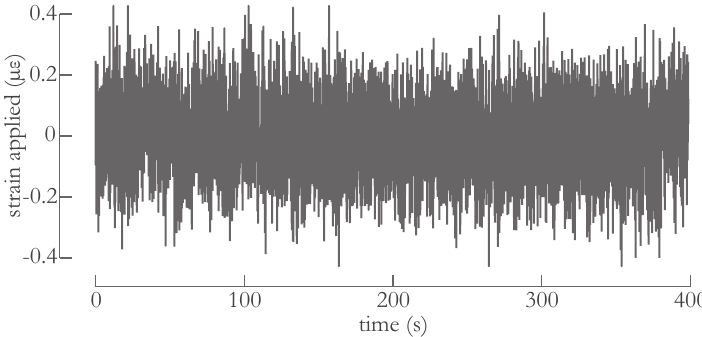
Figure 2. Owing to the phase-correlation approach to demodulation, the reflected spectral information of the FBGs and the (temperature) controlled environment, the strain resolution (determined as the standard deviation of the noise) was approximately 0.2 µ(cid:15)